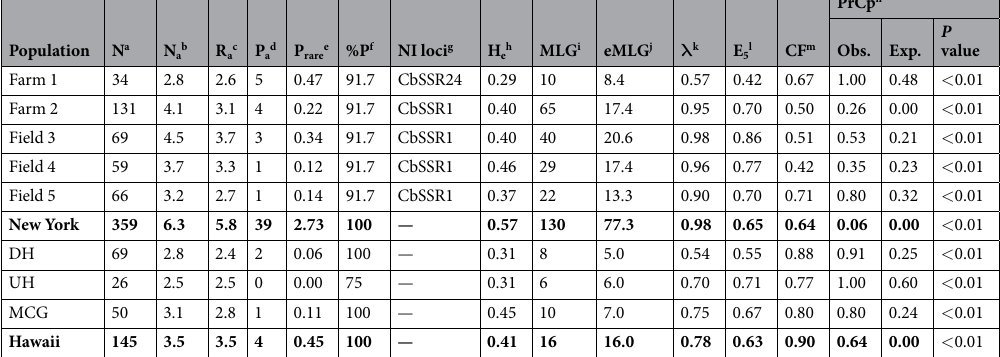
Table 3. Indices of genetic diversity for Cercospora beticola populations collected from New York and Hawaii, 2015. a N = population size after clone-correction to leaf level; b N a = mean number of alleles per locus; c R = allelic richness after rarefaction to the smallest sample size; d P = number of private alleles; e P = number a a rare of private allele after rarefaction to the smallest sample size; f %P = percent polymorphic loci defined as loci with a frequency of at least 0.01; g NI loci = non-informative (monomorphic) loci; h H e = Nei’s index of gene diversity defined as the probability that two randomly chosen alleles are different; i MLG = number of multi- locus genotypes: MLGs in the total population is lower than the sum of MLGs of all populations because multiple MLGs occurred in more than one population, j eMLGs = expected number of MLGs after rarefaction; k λ = Simpson’s complement index defined as the probability that two genotypes randomly chosen from the population are different; l E 5 = population evenness which is an estimation of the uniformity in distribution of the MLGs; m CF = clonal fraction; n PrCP = proportion of phylogenetically compatible pairs of loci, where Obs. denotes the observed value and Exp. denotes the PrCP value expected from a randomly recombined data set.